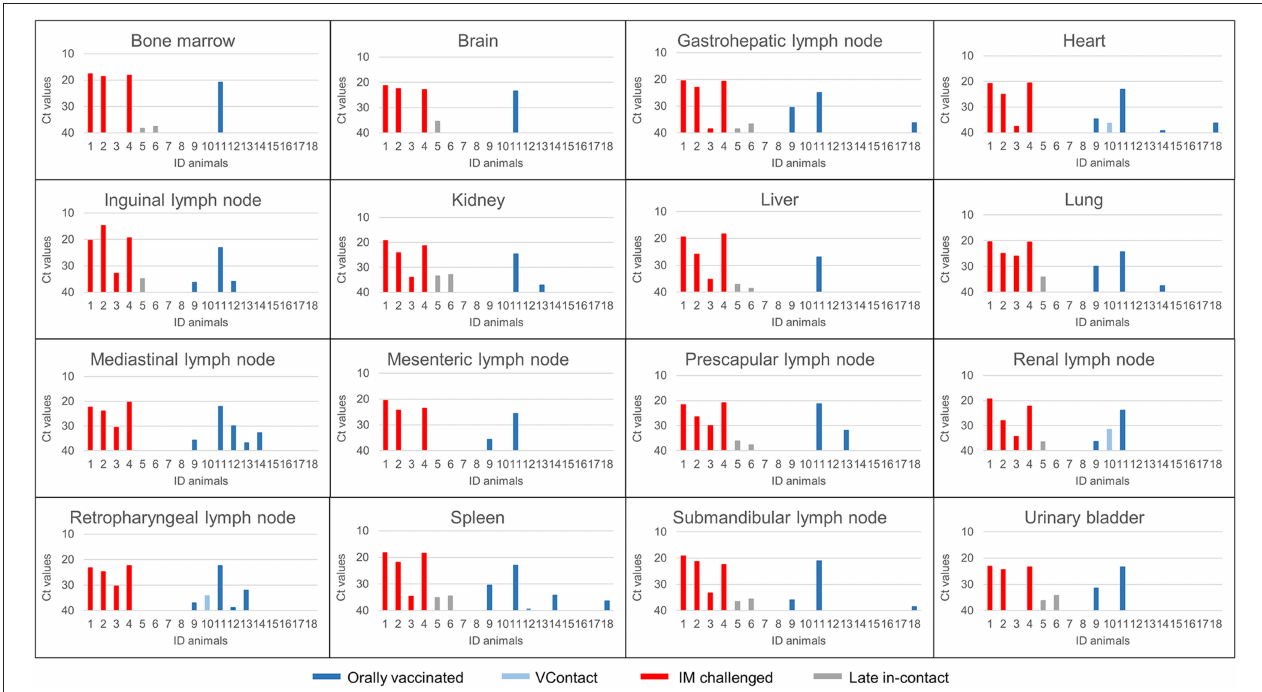
FIGURE 5 | ASFV DNA levels (Ct values from real-time PCR) in post-mortem tissues from animals orally vaccinated with Lv17/WB/Rie1 (dark blue), exposed through contact (VContact, light blue), intramuscularly challenged controls inoculated with virulent ASFV Arm07 (red) and late in-contact wild boar (gray).The unique orally vaccinated animal that did not survive the challenge (ID11) gave strongly positive results in several tissues (Ct = 23.32 ± 1.60), similar to the intramuscularly challenged